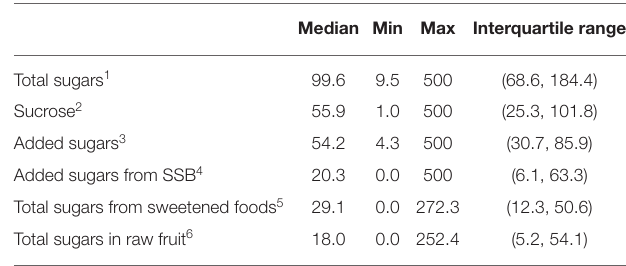
TABLE 2 | Sugars intakes reported by six definitions estimated from a 36 item TABLE 1 | Characteristics of study participants of the complete sample and the food frequency questionnaire (g/day). subset of participants with red blood cell samples. Complete sample, RBC subset, n = 175 n = 36